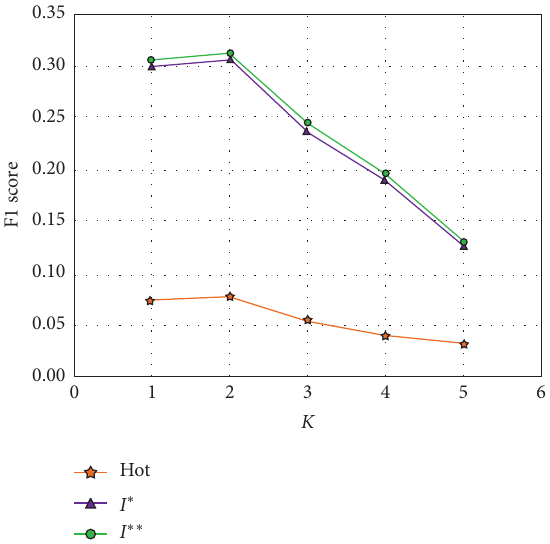
Figure 12: Comparison of news recommendation results under different key information extraction